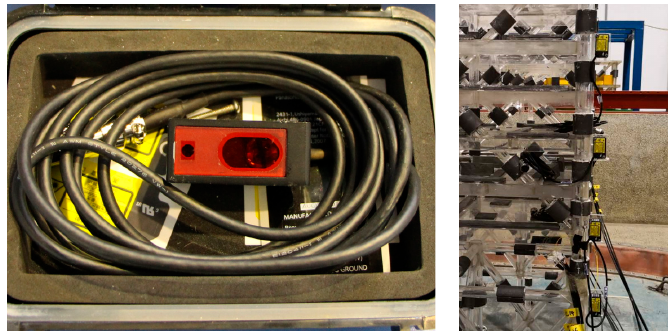
Figure 7. The experimental layout of the laser displacement meter.